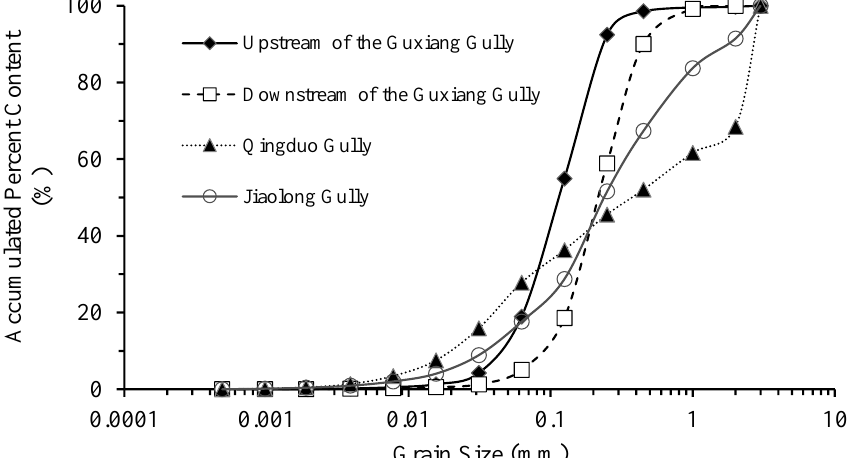
Figure 3. Grain size characteristics of samples from typical debris flow gullies in field investigation.